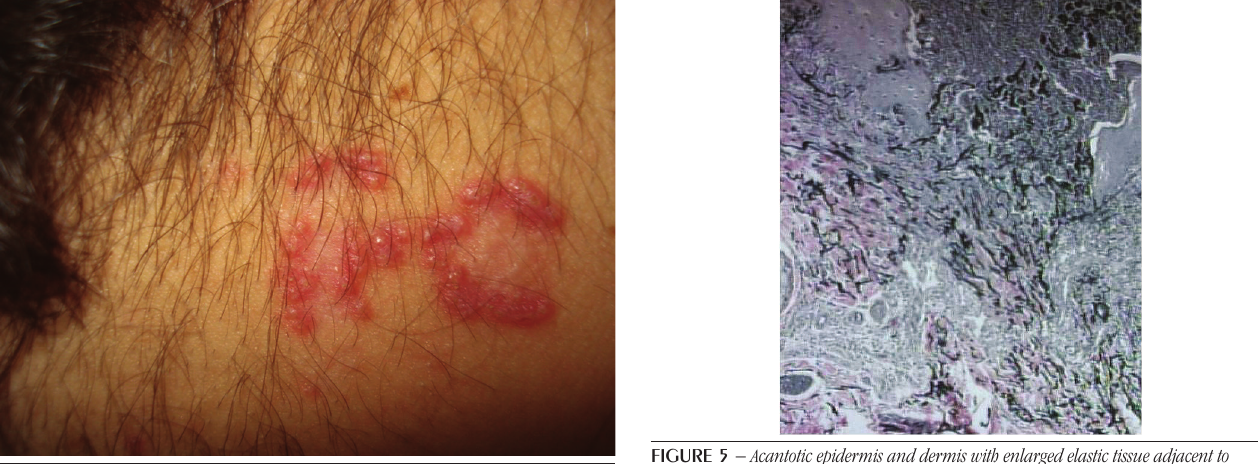
FigurE 2 − Erythematous keratotic papules arranged in a semi-circular pattern in the neck